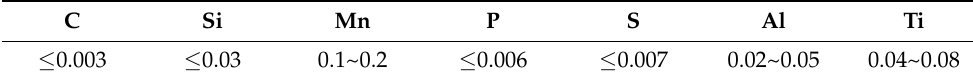
Table 1. The main chemical composition of IF steel slab.